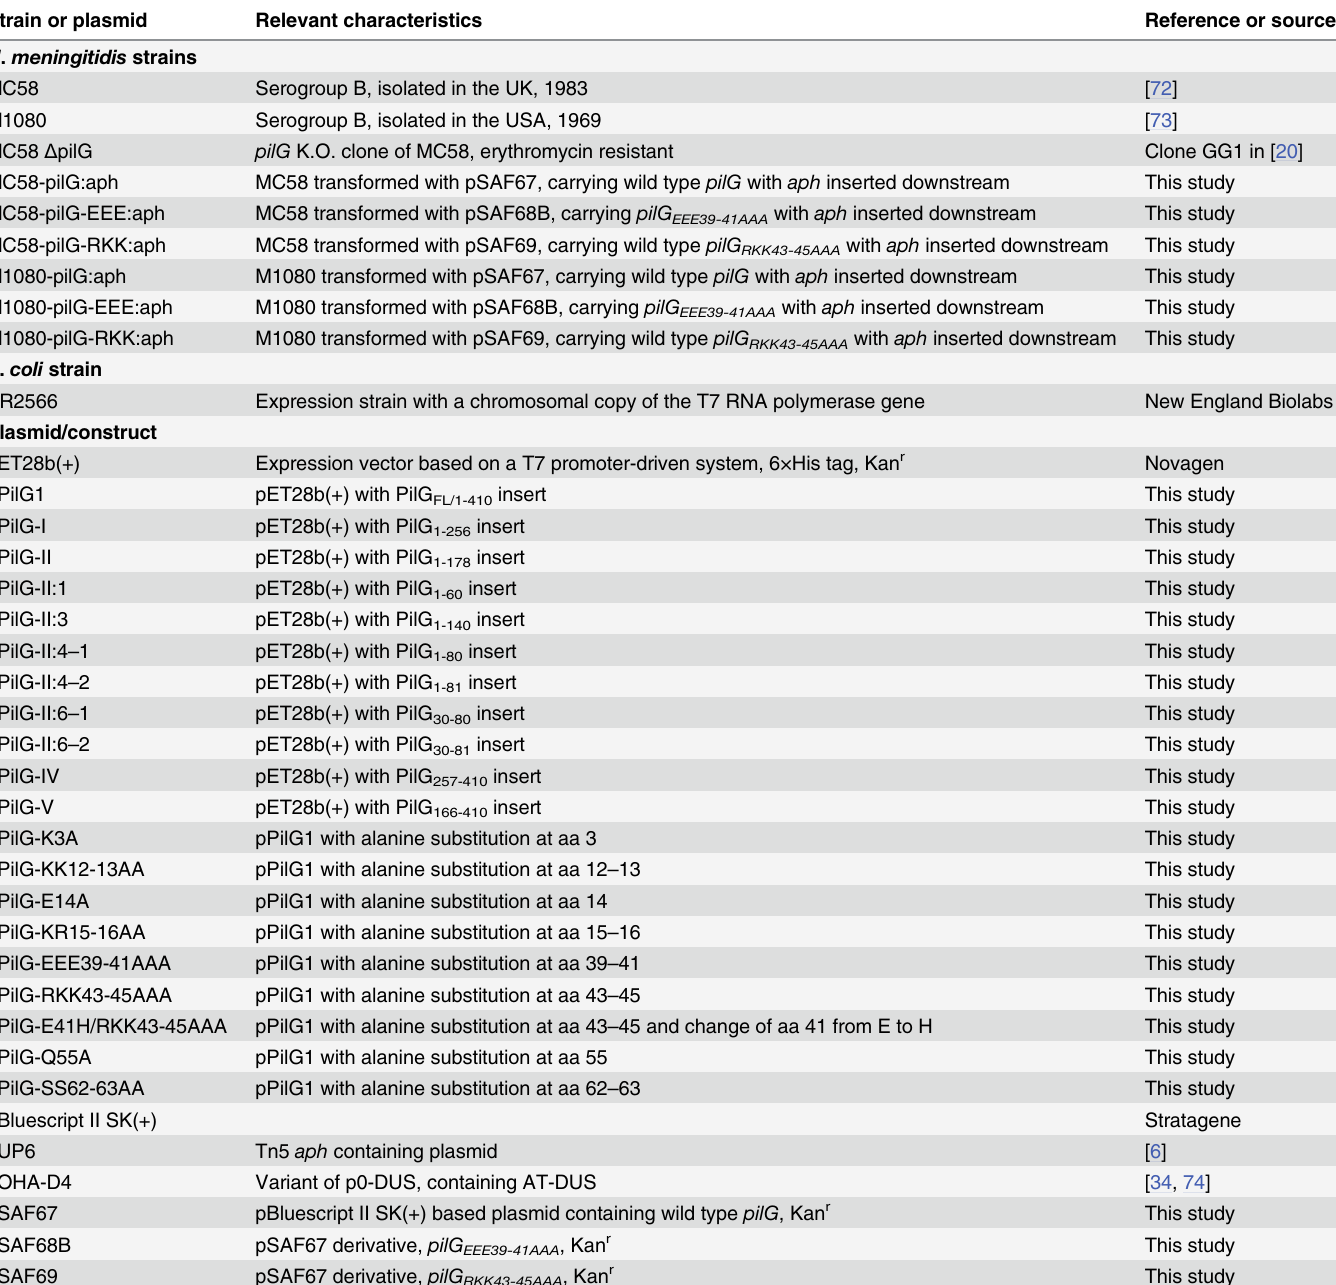
Table 1. Strains, plasmids and constructs employed in the study. Strain or